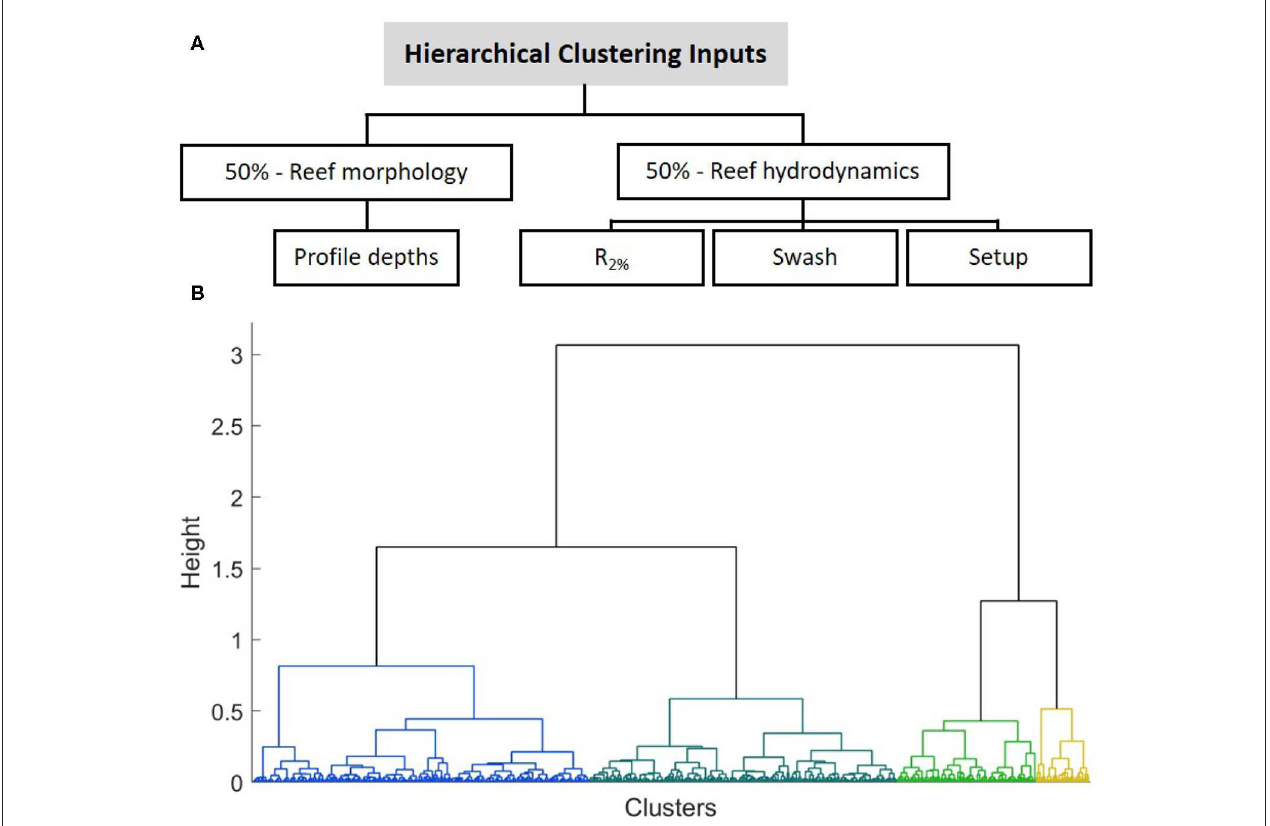
FIGURE 5 | The inputs used for the hierarchical clustering algorithm, (A) highlighting the weighting assigned to the inputs; morphology and hydrodynamics separated into R 2 % , setup and swash. (B) The dendrogram used to visualize the hierarchical clustering results of the 500 initial representative cluster profiles (iRCPs). The coloring represents an example of the grouping of the 500 iRCPs if a height cutoff value of 1 is used, forming four